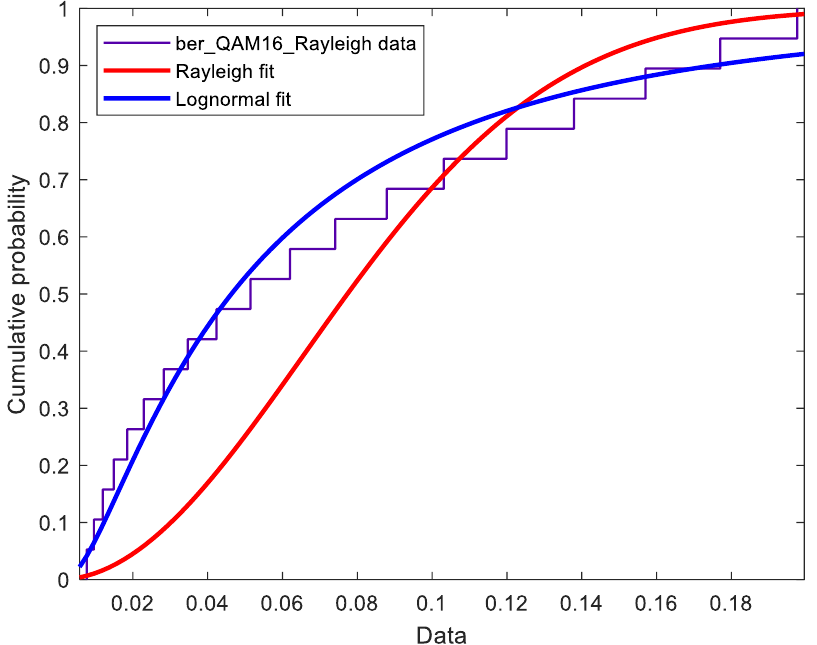
Figure 5. BER simulation results for an NLOS channel employing the QAM-16 modulation scheme: Rayleigh and log-normal fitting curves.